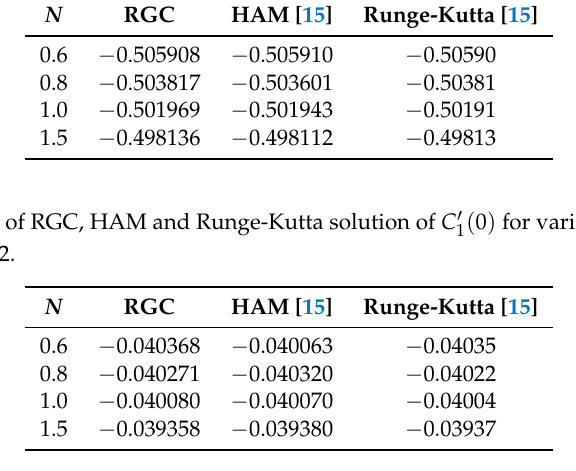
( 0 ) for various values of Sc while 0